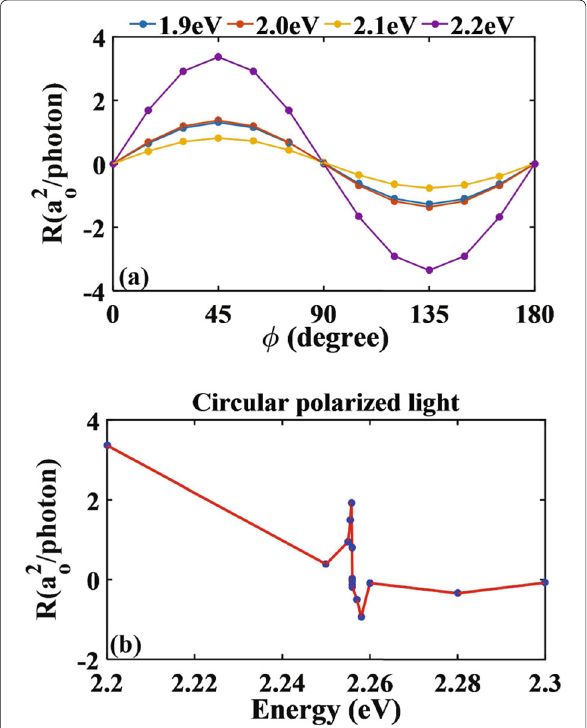
Fig. 6 Nitrogen-doped monolayer MoS 2 is irradiated by the elliptical polarized light perpendicularly. a , b The variations of photoresponse function with the phase angles and the energies of circularly polarized light for φ = 45 o ,